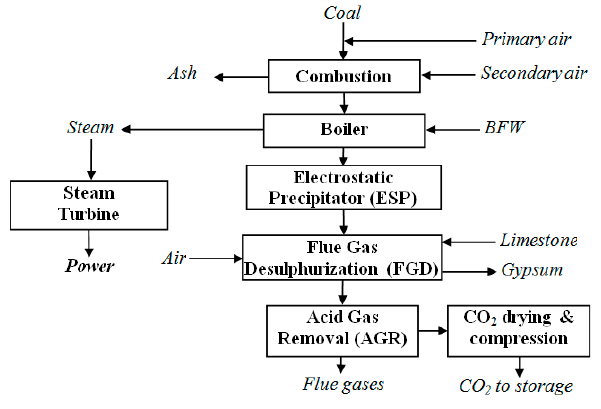
Figure 4. Decarbonized super-critical power plant.